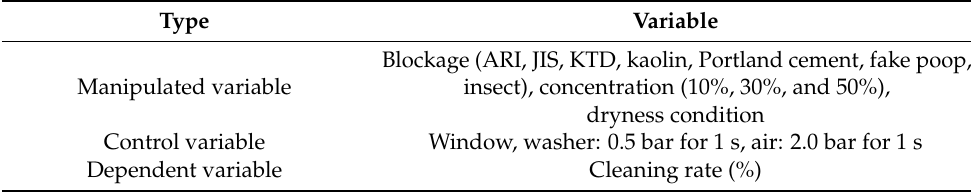
Table 2. Main factors of the